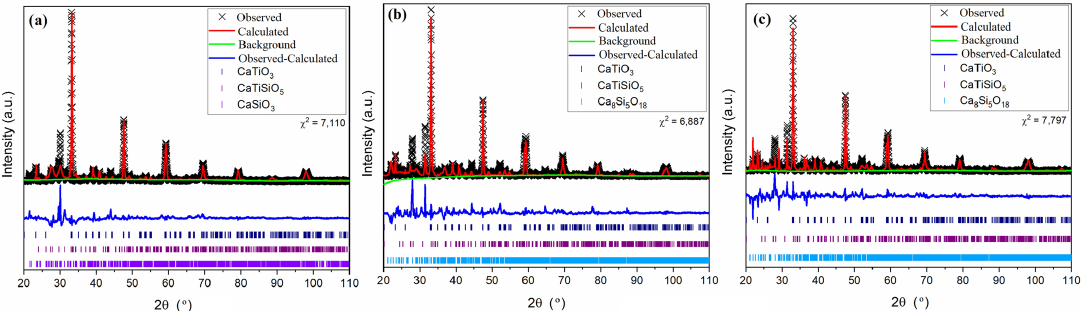
Figure 5. Structure refinement of glass-ceramics obtained from Ca Glass treated at 960 ºC during (a) 2 hs, (b) 4 hs and (c) 6 Table 2. Phase percentages estimated by the structure refinement for Ca Glass treated at 960 ºC. The convergence parameters are indicated.